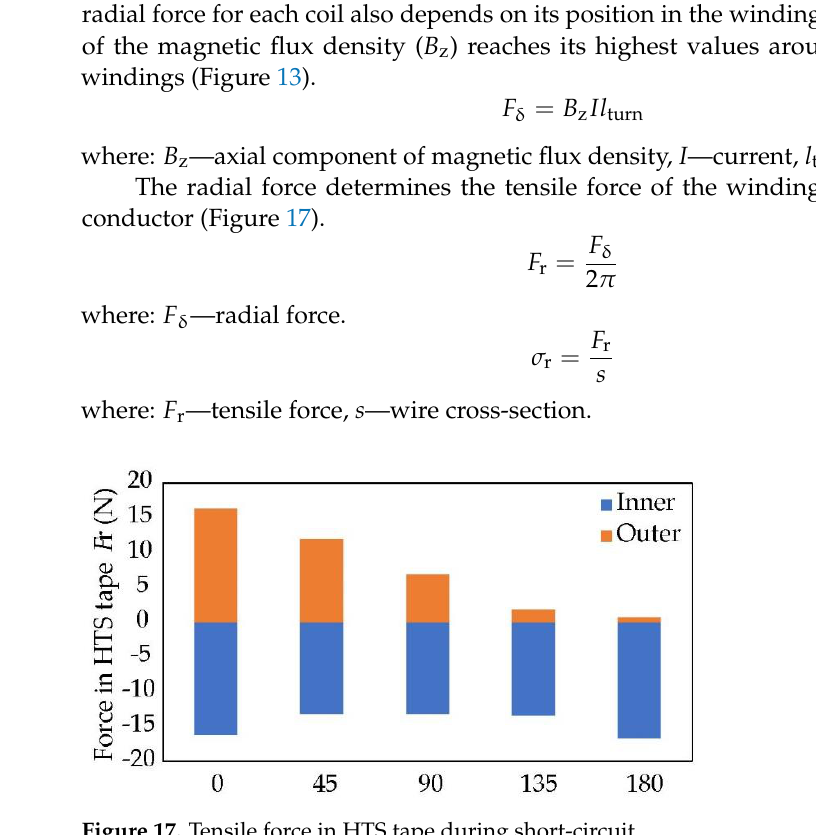
Figure 17. Tensile force in HTS tape during short-circuit.